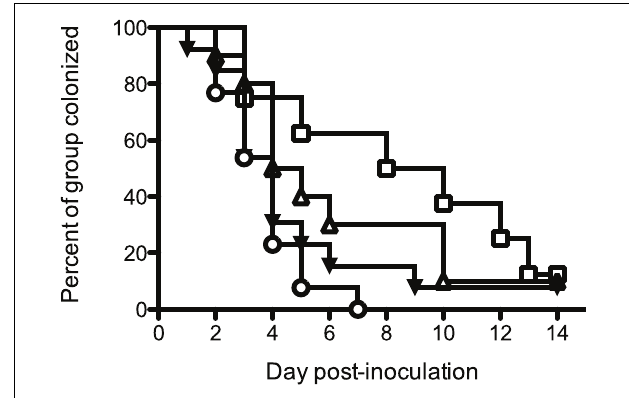
FIGURE 3 |A PorB-VRP vaccine for gonorrhea in the mouse is no more FIGURE 2 | PorB-VRP × 2 in FP plus boost with rrPorB in FP protects effective than a vaccine composed of the same vector expressing an against vaginal infection in the mouse model. Three- to four-week old irrelevant peptide. BALB/c female mice were immunized in FP with either female BALB/c mice were divided randomly into four groups of 24 and PBS three times ( (cid:3) , mock, n = 17); PBS twice with a single boost of rrPorB vaccinated three times at 2weeks interval. Mice were immunized with ( (cid:5) , n = 17); FA1090 PorB-VRP twice with a single boost of rrPorB ( ◦ , n = 18); three doses of PBS ( (cid:3) , mock, n = 8), rrPorB ( (cid:2) , n = 10), PorB-VRP ( (cid:4) , ◦ or influenza HA-VRP twice, also boosted once with rrPorB ( • , n = 18).The n = 13) or 2 doses of PorB-VRP with 1 boost of rrPorB ( , n = 13). All doses rrPorB boosts consisted of 10 μ g of FA1090 rrPorB in 10 μ l PBS mixed 1:1 of immunogens, in a volume of 20 μ l, were given through the left footpad with Ribi-700 adjuvant. Immunizations were at 2-week intervals.TheVRP after the animals had been anesthetized.Two weeks after the last boost, preparations were administered in a dose of about 1 × 10 6 particles without mice in the diestrus phase were implanted with estradiol pellets and additional adjuvant.The volume of all immunizations was 20 μ l.Two weeks treated with antibiotic.They were inoculated intravaginally with 1 × 10 6 CFU after the final immunization, mice in diestrus were recruited for the of FA1090 2days later. Daily vaginal cultures were processed for total challenge with FA1090, as in Table 1 . Days to last positive culture are recovery from the infection. Days to last positive culture are shown. shown. Log rank was used to compare all four groups; results were Log-rank test for equality to the Mock group yielded the following p values: significantly different among the groups ( p = 0.03).The only pairwise PorB-VRP + rrPorB boost, p = < 0.01; PorB-VRP without rrPorB boost, comparisons which were significantly different ( p < 0.05) were PBS alone p = 0.11; rrPorB alone, p = 0.40. vs HA-VRP + rrPorB ( p = 0.03), PBS + rrPorB vs HA-VRP + rrPorB ( p = 0.01), and PBS + rrPorB vs PorB-VRP + rrPorB ( p =